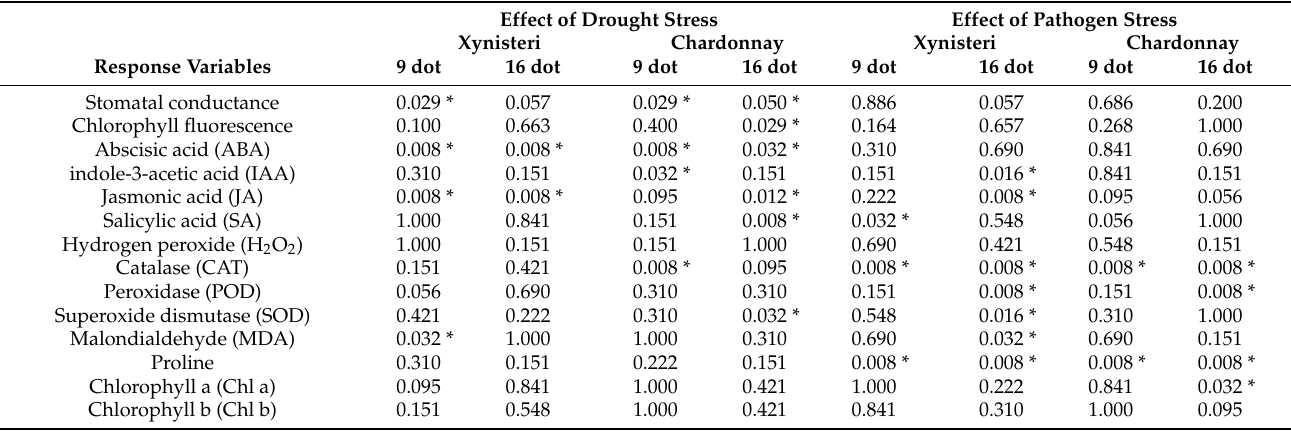
Figure 4. The impact of drought and pathogen stress on plant physiological parameters. Xynisteri (XYN) and Chardonnay (CHAR) plants were subjected to 7 or 14 days of full (FI) or deficit (DI) irrigation before in planta inoculation with water (Ctrl) or P. viticola (Path) (continued exposure to full/deficit irrigation; see Figure 1). Stomatal conductance and chlorophyll fluorescence were measured at 1.5 days post inoculation (dpi), corresponding to 9 or 16 days of irrigation treatment (dot). For the effect of drought stress, the fully irrigated and deficit-irrigated control plants should be compared. For the effect of pathogen stress, water-inoculated and pathogen-inoculated fully irrigated plants should be compared. The bars and error bars show the mean and the standard deviation, respectively. Table 1. p -values for the single drought stress and single pathogen stress. Significant differences ( p ≤ 0.05) are marked with an asterisk. This analysis was performed on subsets of the data to exclude interactions. For the effect of single drought stress, fully irrigated and deficit-irrigated, water-inoculated plants were compared (control treatments of the continued exposure to full/deficit irrigation; see Figure 1). For the effect of single pathogen stress, water-inoculated and pathogen-inoculated fully irrigated plants were compared (continued exposure to full irrigation; see Figure 1).